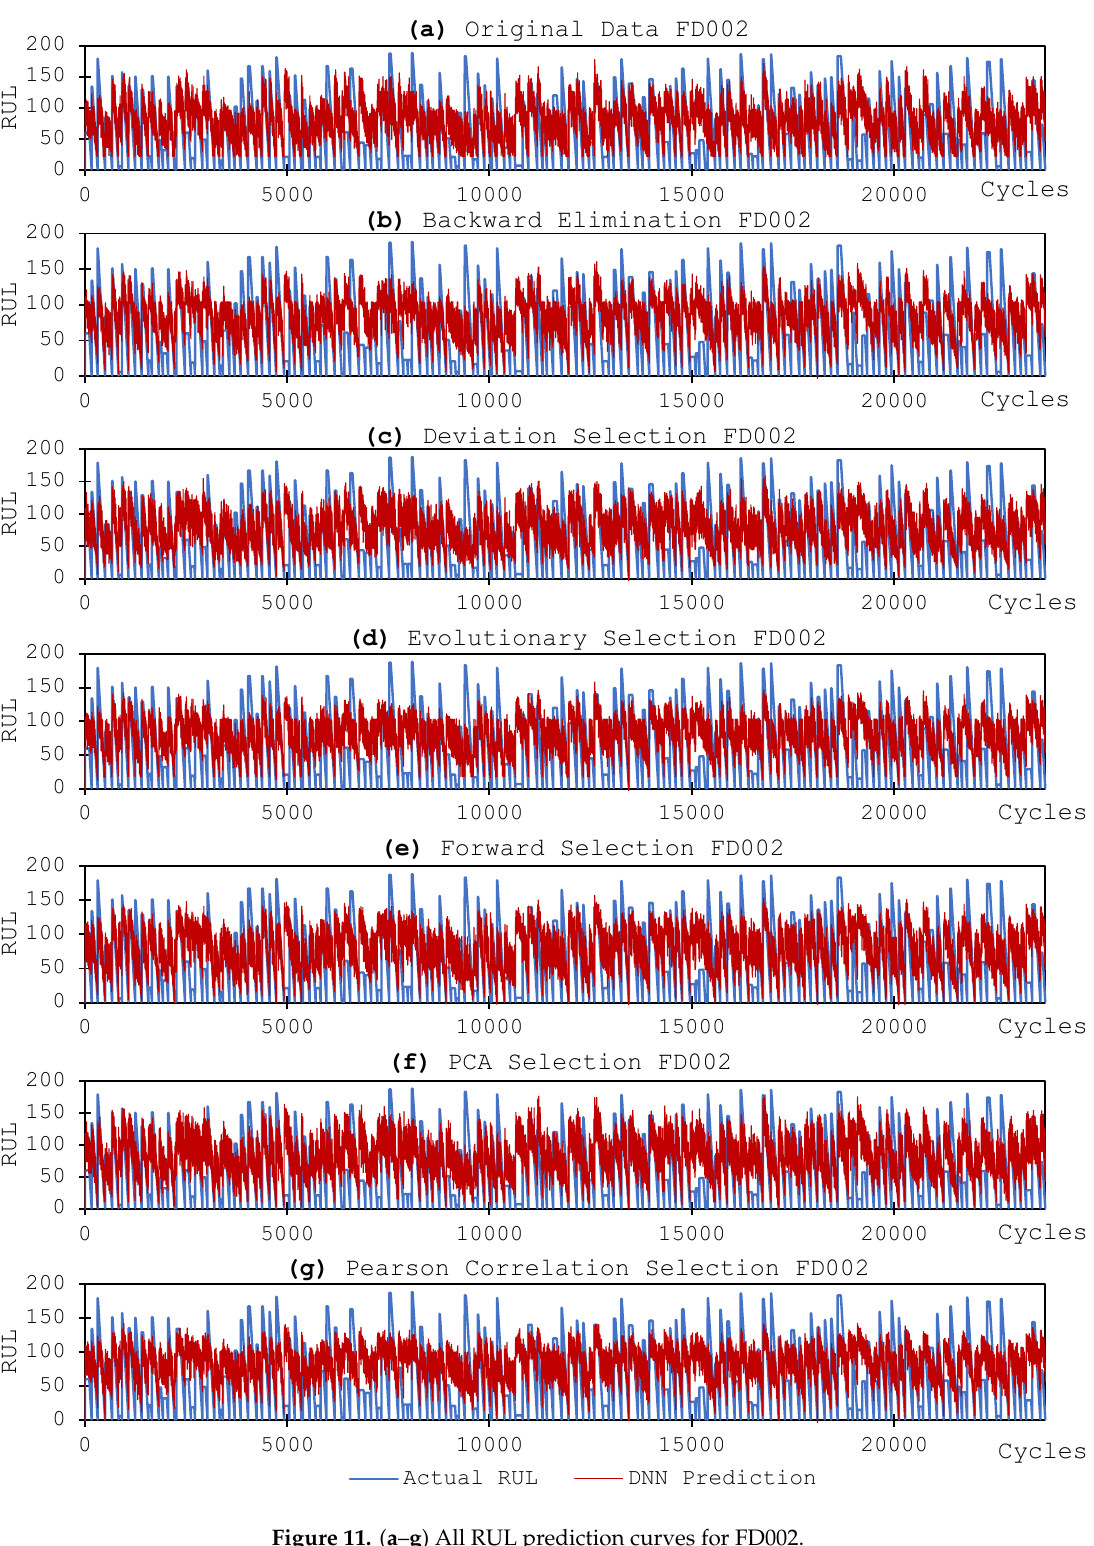
Figure 11. ( a – g ) All RUL prediction curves for FD002.